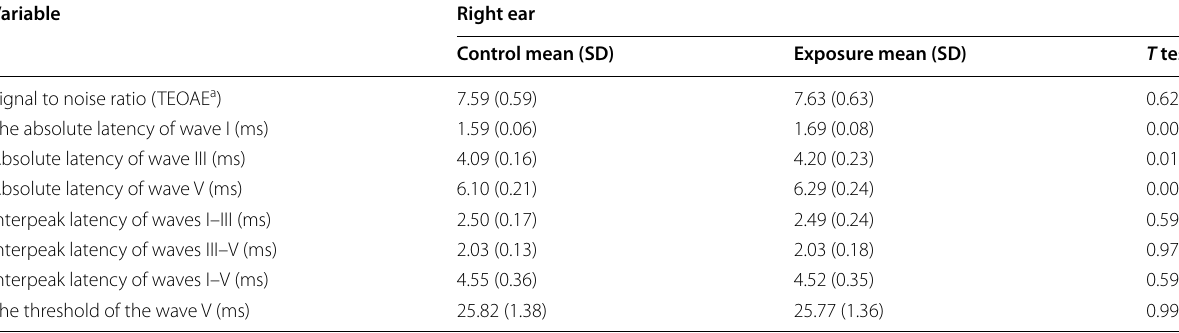
Table 2 The comparison of absolute latency of waves between two groups in two